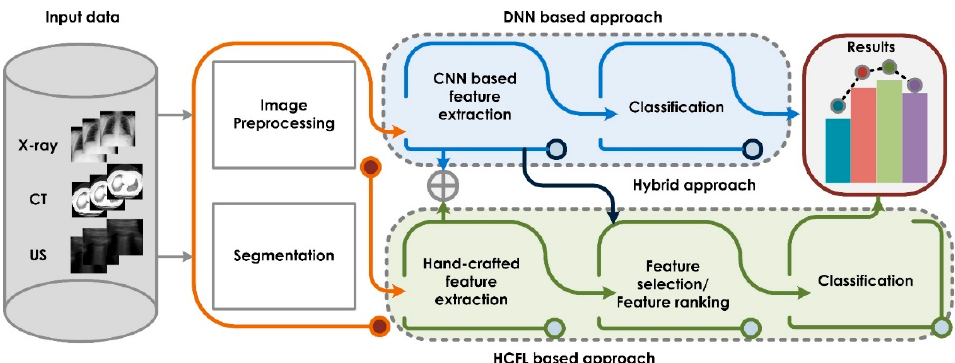
Figure 3. The complete framework to detect COVID-19 using various approaches.